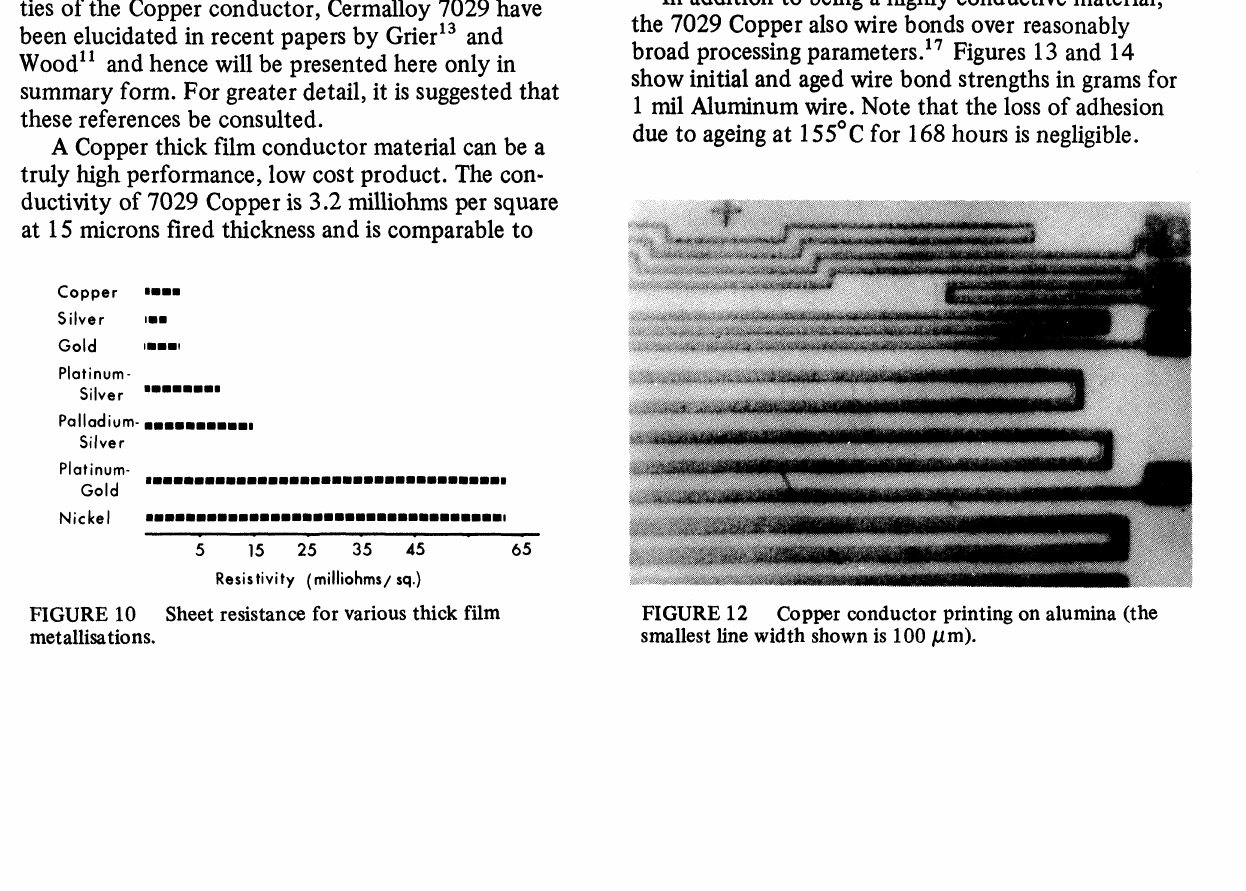
1 rail Aluminum wire. Note that the loss of adhesion due to ageing at 155C for 168 hours is negligible.